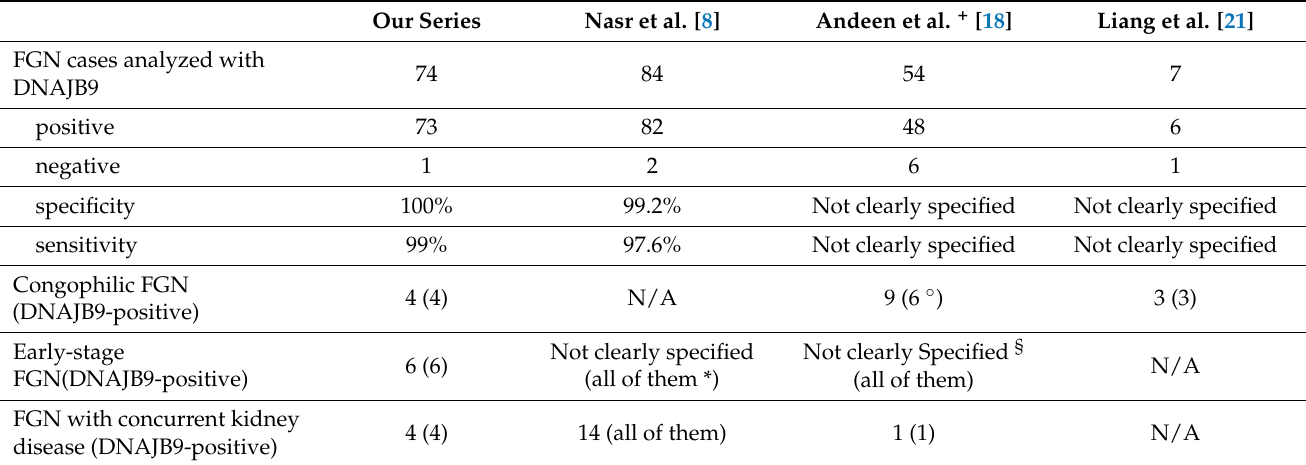
Table 6. Comparison of studies assessing DNAJB9 in FGN